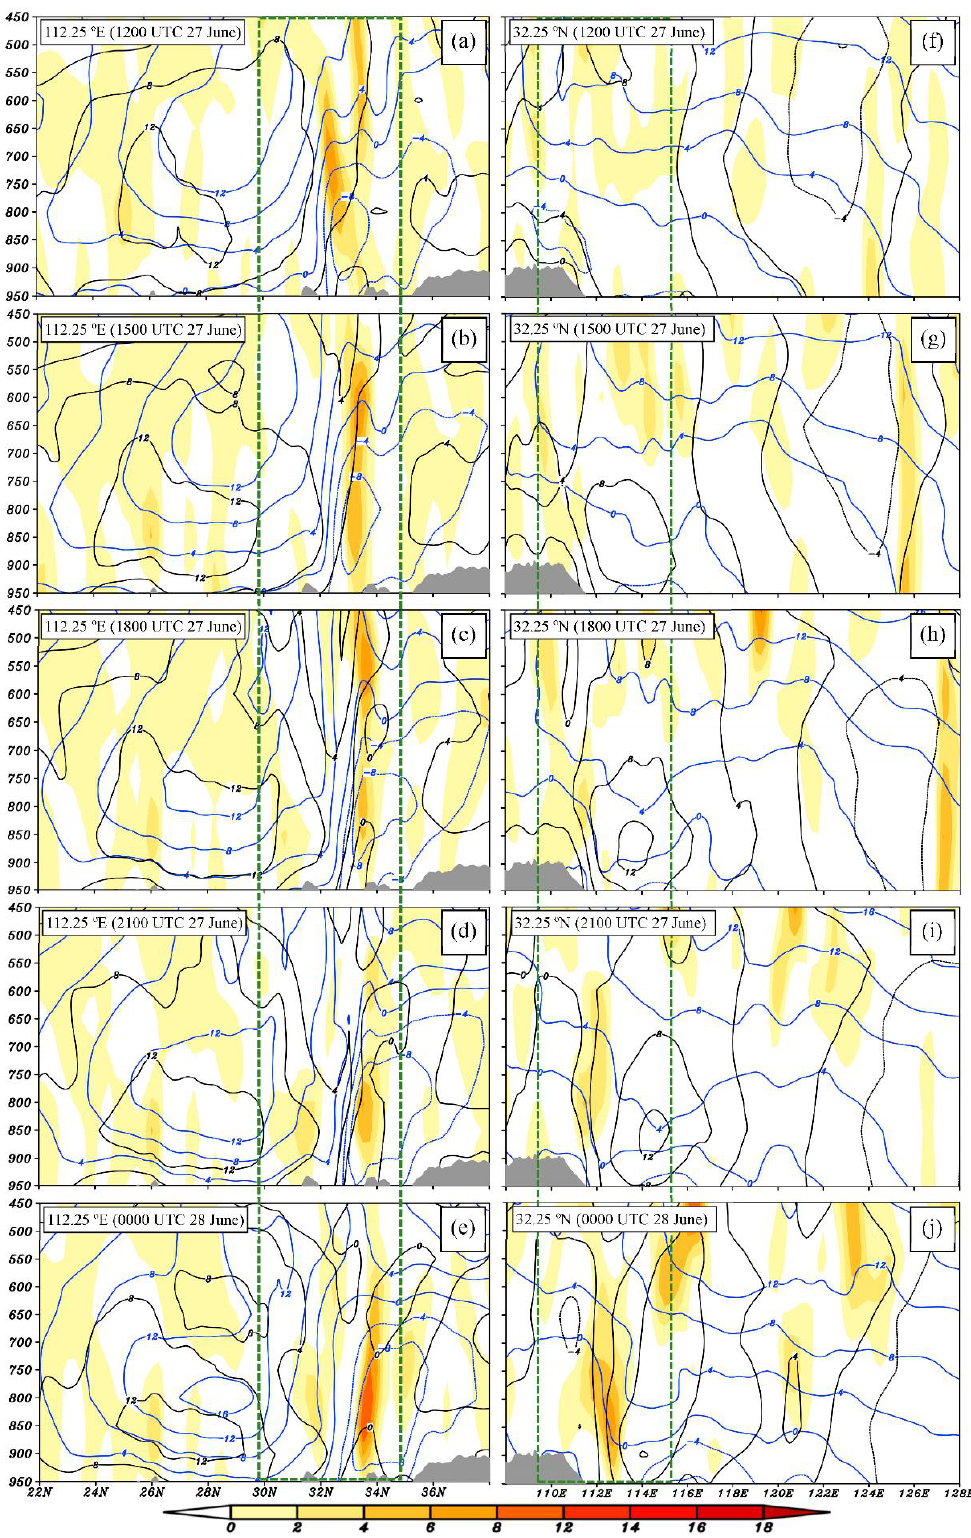
Figure 9. Panels ( a – e ) show the zonally (from 109.25° E to 115.25° E) averaged term HAV (shading, units: 10 −9 s −2 ), zonal wind (blue lines, units: m s −1 ), and meridional wind (black lines, units: m s −1 ). Panels ( f – j ) illustrate the meridionally (from 29.75° N to 34.75° N) averaged term HAV (shading, units: 10 −9 s −2 ), zonal wind (blue lines, units: m s −1 ), and meridional wind (black lines, units: m s −1 ). Grey shading shows the terrain, and the green dashed lines mark the central location of the mesoscale vortex. Y labels in all figures are pressure (units: hPa).